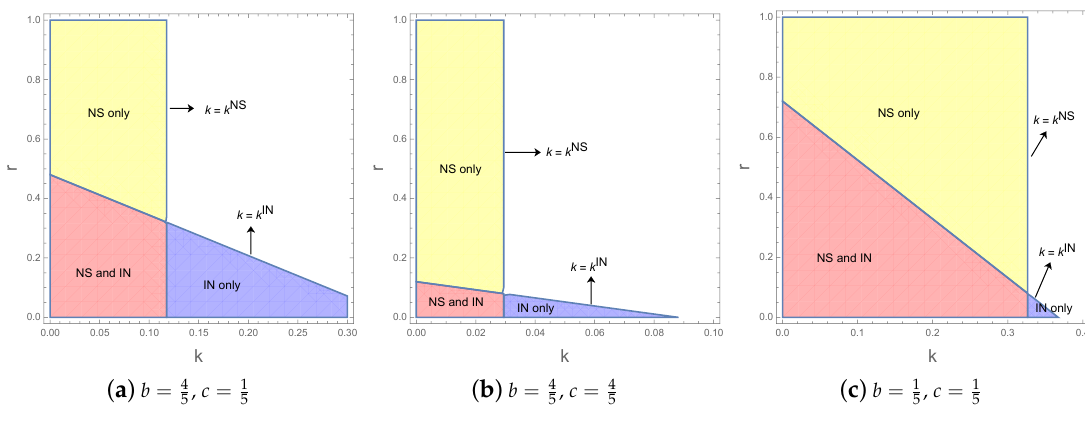
Figure 1. The feasible